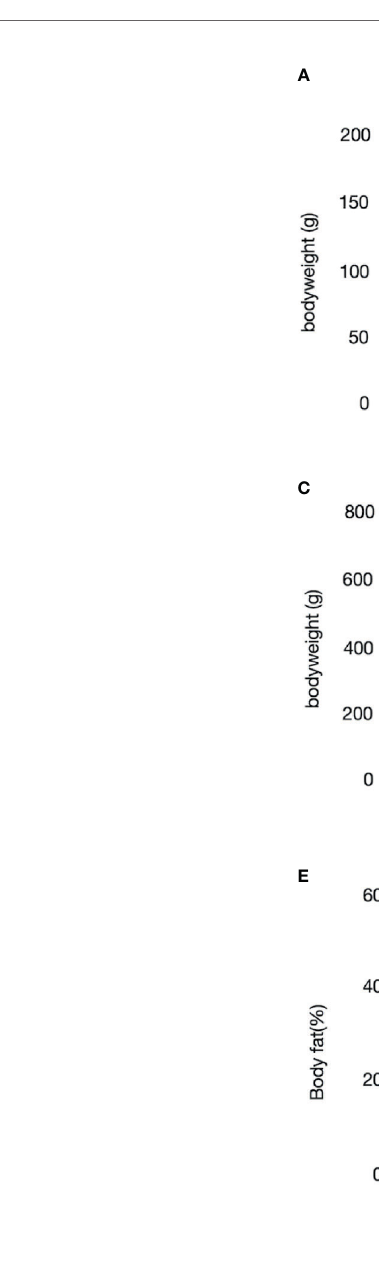
FIGURE 2 | Bodyweights and body fat ratio. Plots of the bodyweight before (5-week-old) ( A for males and B for females) and after (13-week-old) ( C for males and D for females) exposure to the high-fat diet (HFD) or standard chow (SC), and the body fat percentage after exposure to the HFD or SC (13-week-old) ( E for males and F for females) are shown. Values are presented as means ± SEM. Statistical analysis was performed using one-way ANOVA followed by Tukey ’ s post hoc test for multiple comparisons. n.s., not signi fi cant (p ≥